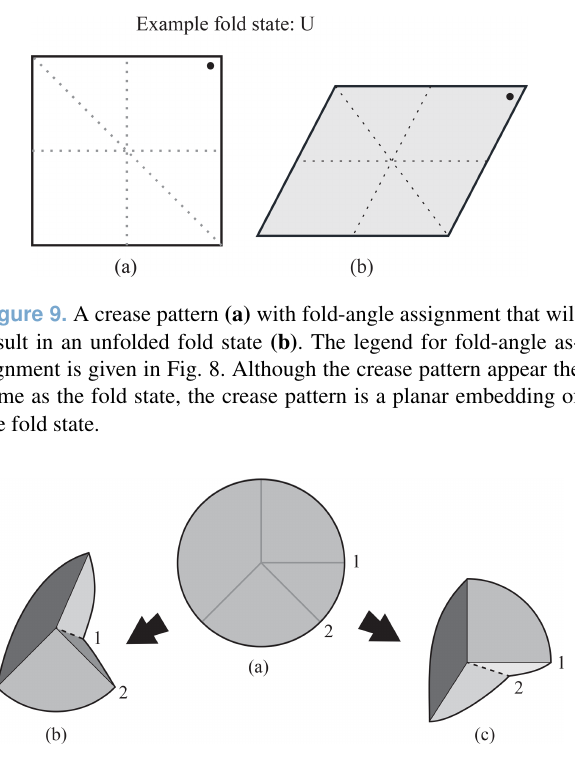
Figure 10. Crease patterns in the unfolded state (a) can bifurcate so that either fold 1 in fold state (b) or 2 in fold state (c) (represented by the dotted line) has a fold angle with an opposite sign to the other fold